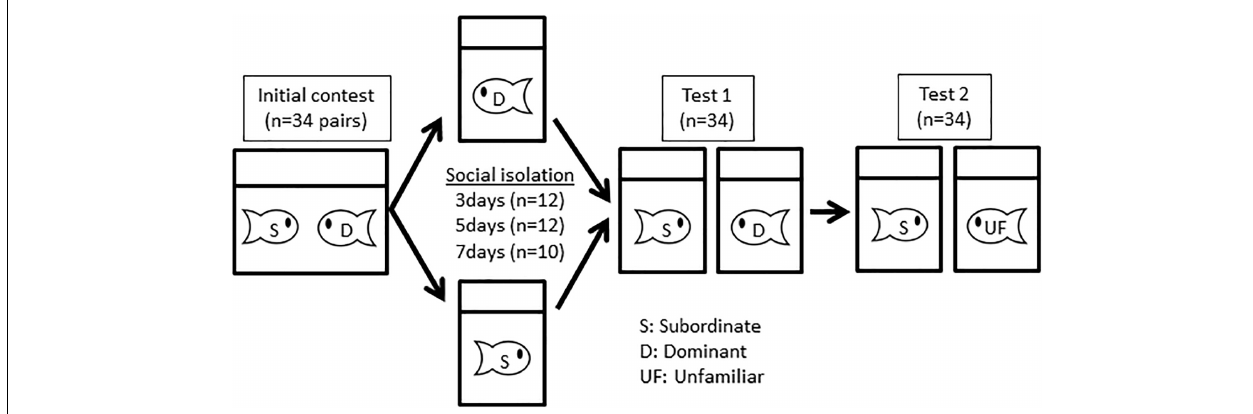
FIGURE 1 | The sequence of the experiment. After the initial contest, two fish were removed and isolated for either 3 ( N = 12 pairs), 5 ( N = 12 pairs), or 7 days ( N = 10 pairs). Then, the subordinates encountered their previous dominants again. S and D indicate subordinate fish and dominant fish, respectively.